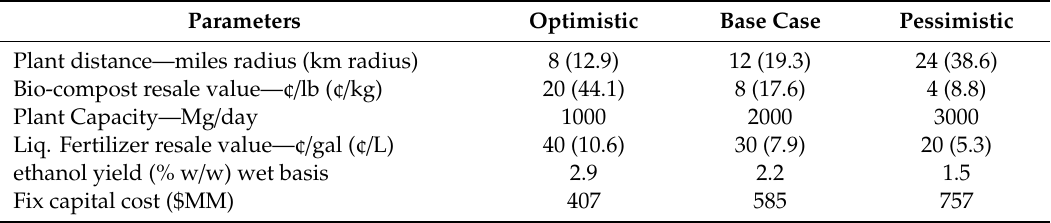
Table 1. Sensitivity analysis parameters for FW fermentation with the membrane distillation separation